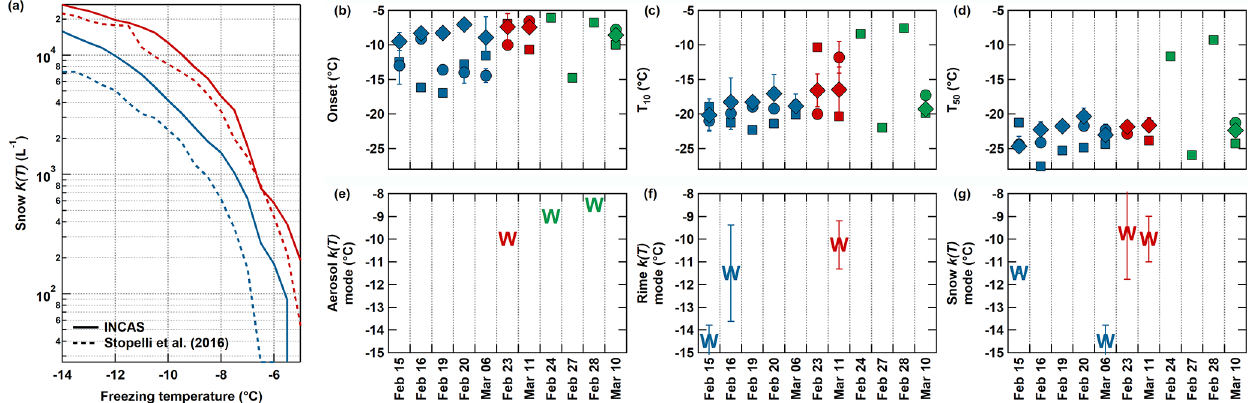
Figure 6. (a) Comparison of INCAS cumulative snow INP concentrations for northwest (blue) and southeast (red) within the same range of those reported by Stopelli et al. (2016) for measurements at JFJ during the 2012–2013 winter season. Summary of INCAS INP concentrations from aerosol (squares), cloud rime (circles), and snow samples (diamonds), including (b) freezing onset temperatures, (c) the temperature in which 10% of drops froze, and (d) the temperature in which 50% of the drops froze calculated from fraction frozen. From the k(T ) spectra, warm-mode temperatures are shown for (e) aerosol, (f) rime, and (g) snow samples. Blue, red, and green markers represent northwesterly cases, southeasterly cases, and SDE and BLI case days, respectively. Some data points overlap and thus plots may appear to not have the same number of points per